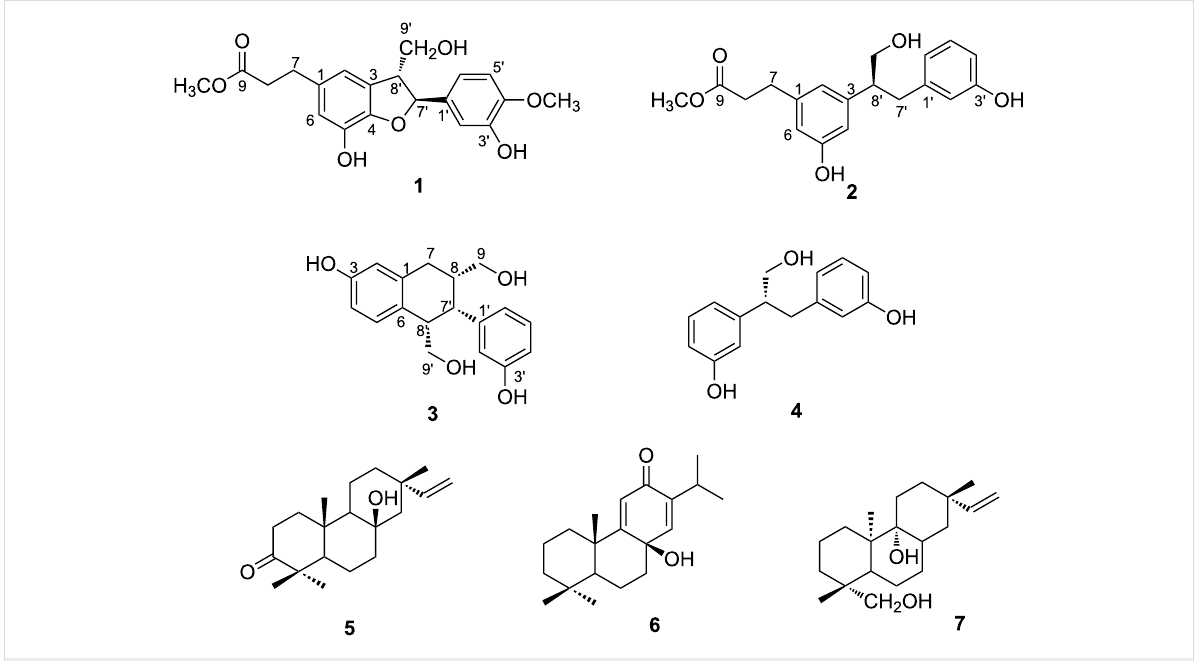
Figure 1: Structures of compounds 1–7 isolated from feces of Trogopterus